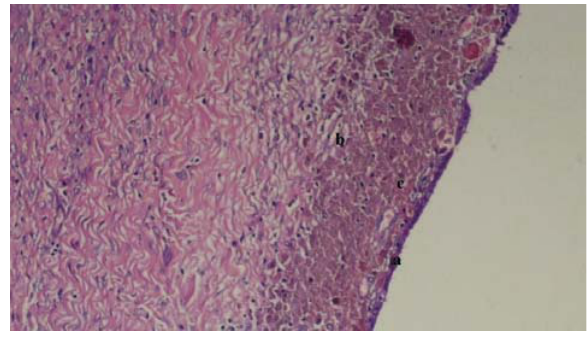
Figure 2: The histopathologic examination showed endometrial epithelium (a), the aggregation of hemosiderin pigments (b) and stroma (c). (Hematoxylin & Eosin) Three weeks after the surgery, the patient was called for a follow-up examination. The patient was asymptomatic and there was no surgery-related